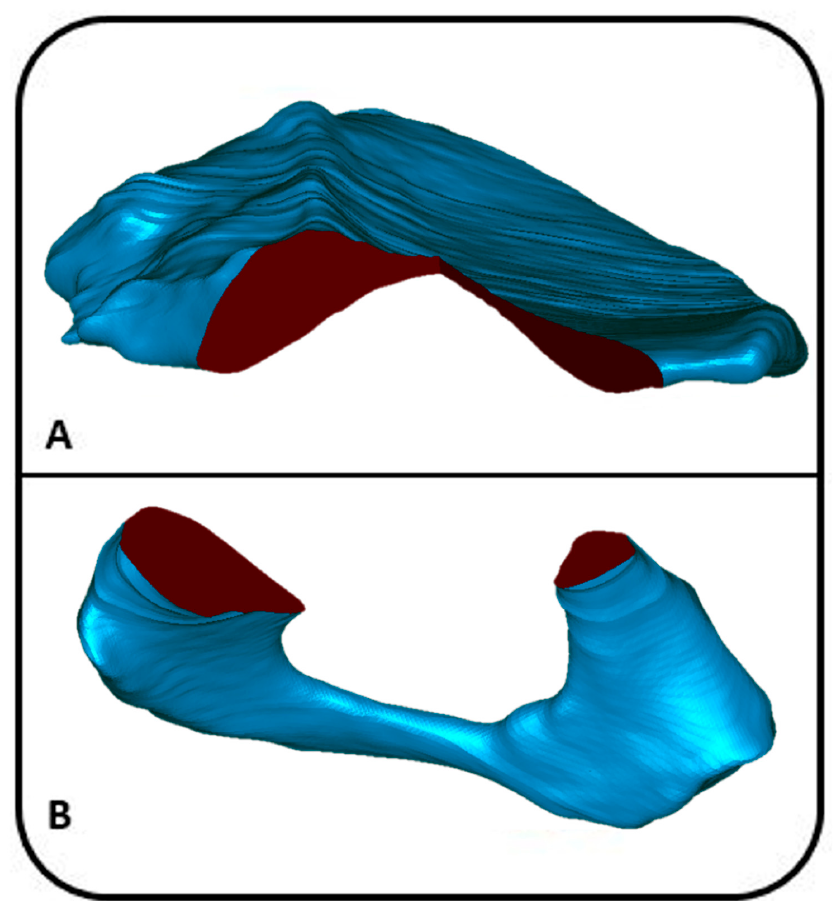
Figure 7. Depiction of the sections (in red) at the affected hemipelvis, supposed to host the implant, the upper part in the ilium ( A ), and the lower part in the ischium and pubis ( B ).